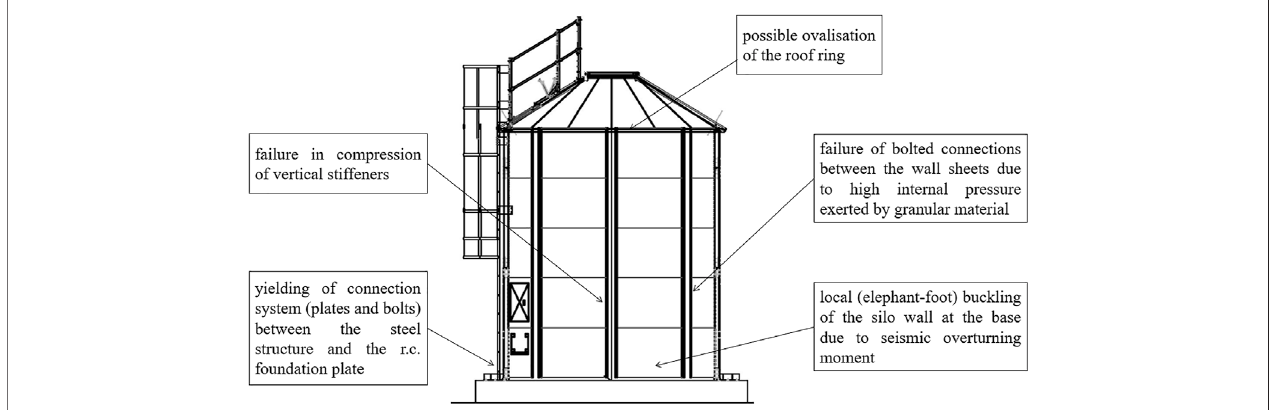
FIGURE 1 | Common failure mechanisms of fl at-bottom fi lled silo systems during earthquake events.